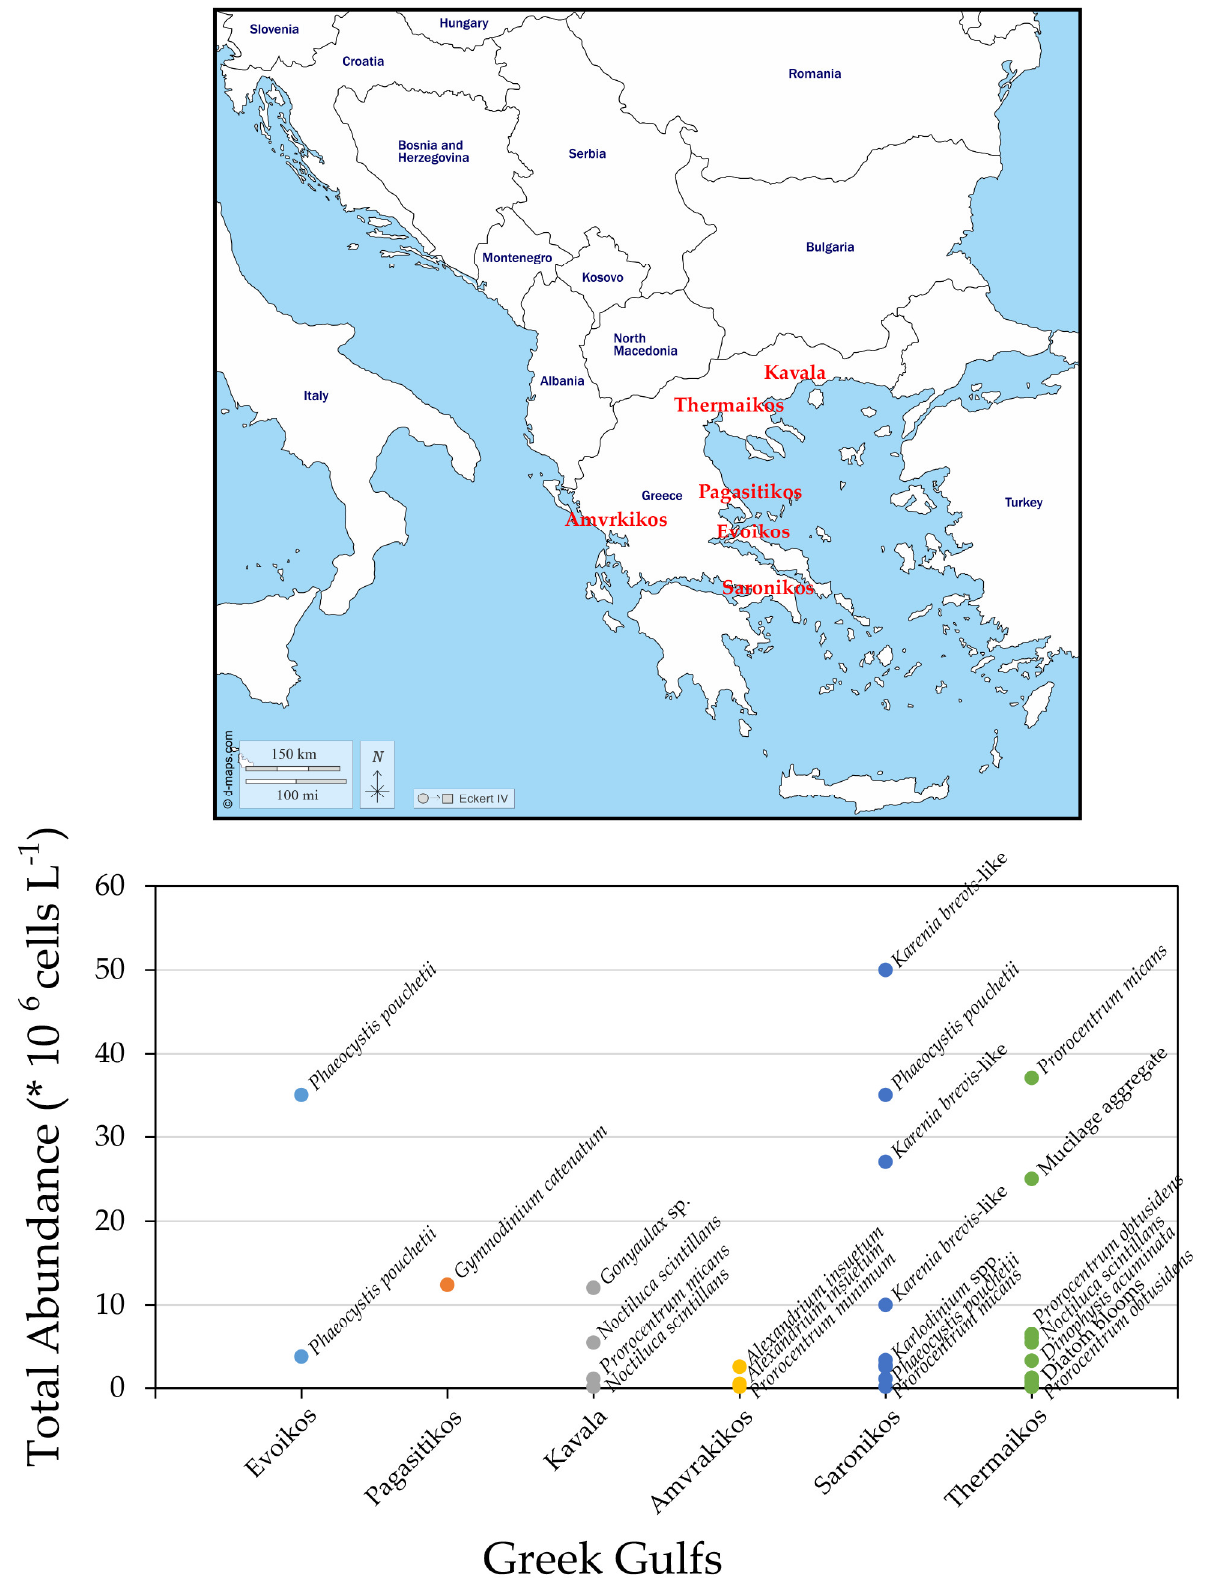
Figure 3. Top : Map of the Baltics with focus on the Greek coastal areas that HABs have been documented. Bottom : Total Figure 3. Top: Map of the Baltics with focus on the Greek coastal areas that Harmful Algal Blooms (HABs) have been abundance of phytoplankton in documented HABs in Greek documented. Bottom: Total abundance of phytoplankton in documented HABs in Greek Gulfs.